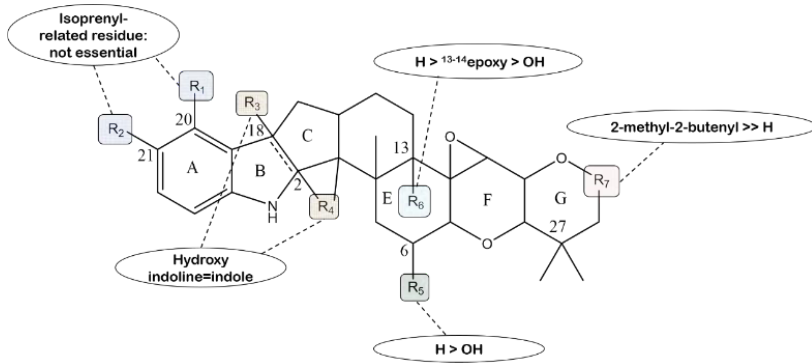
Figure 23. Structure – activity relationship of terpendole indole diterpenes.